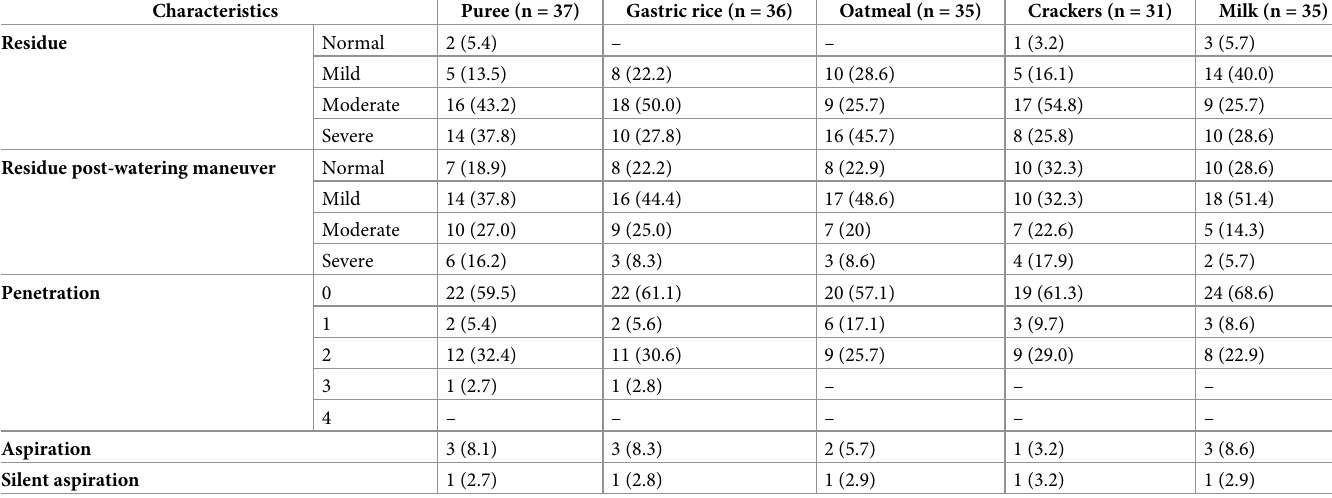
Table 4. The results of swallowing assessment by FEES after foods administration.